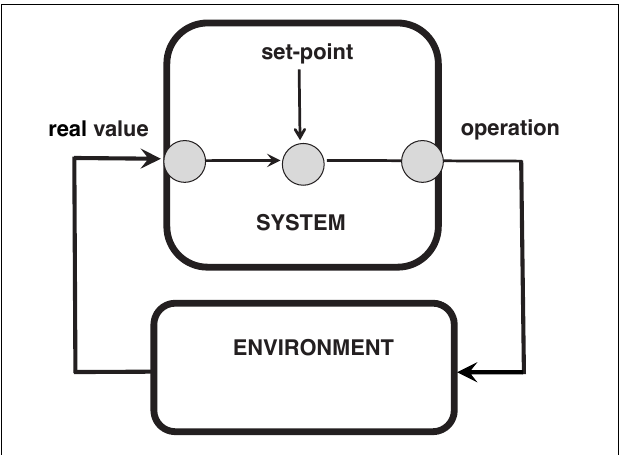
FIGURE 2 | Control loop paradigm (e.g., heating regulation).